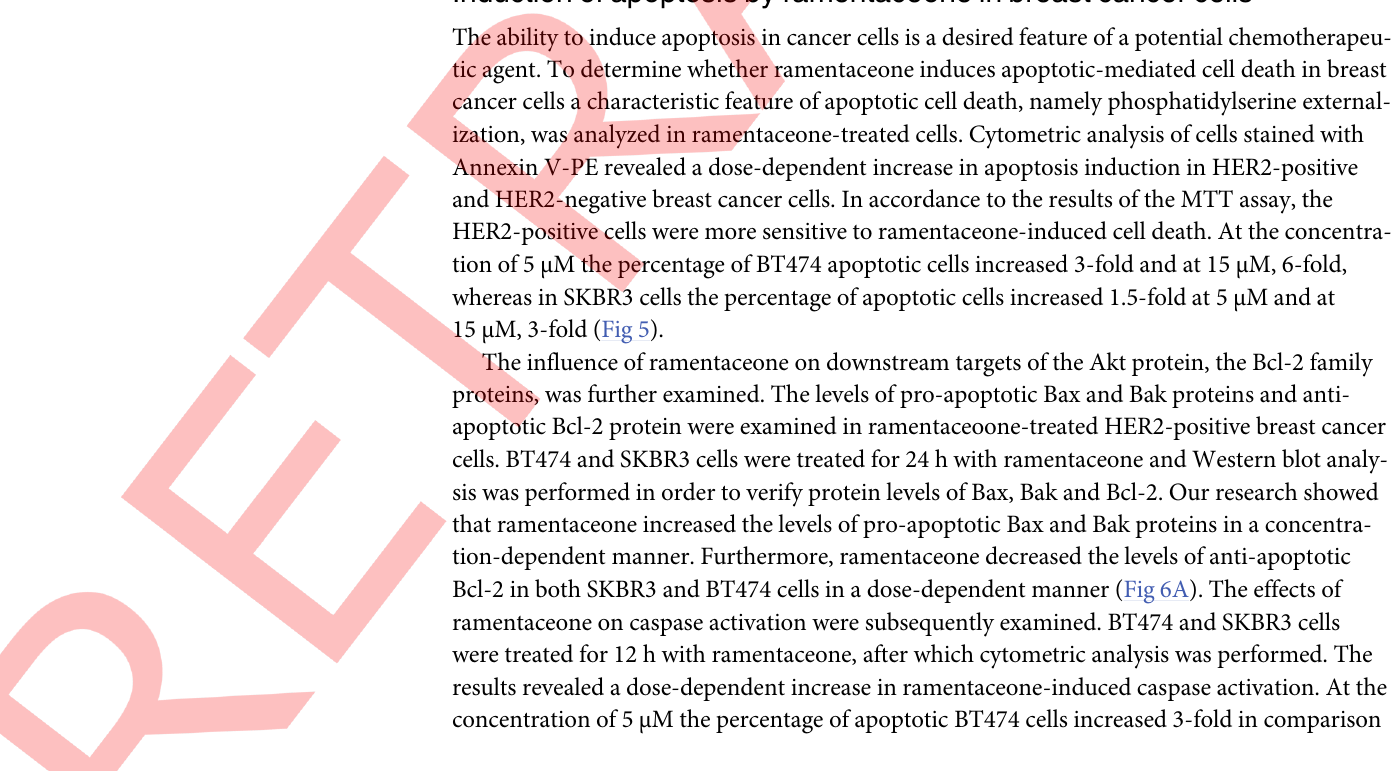
Fig 2. Effects of ramentaceone on the viability of breast cancer cells. (A) Cytotoxic activity of ramentaceone toward HER2-overexpressing (BT474 and SKBR3) and HER2-negative (MCF-7 and MDA-MB-231) breast cancer cells. Cells were treated with ramentaceone (0 – 15 μ M) for 24 h and cell survival was assessed with the MTT assay (n = 3). (B) Influence of ramentaceone on clonogenicity of HER2-positive breast cancer cells, SKBR3 and BT474. Cells were treated with ramentaceone (0 – 15 μ M) for 3 h and allowed to grow for 16 days to form colonies. Values represent mean ± SD of three independent experiments. p < 0.05 ( * ) indicates differences between control and ramentaceone-treated